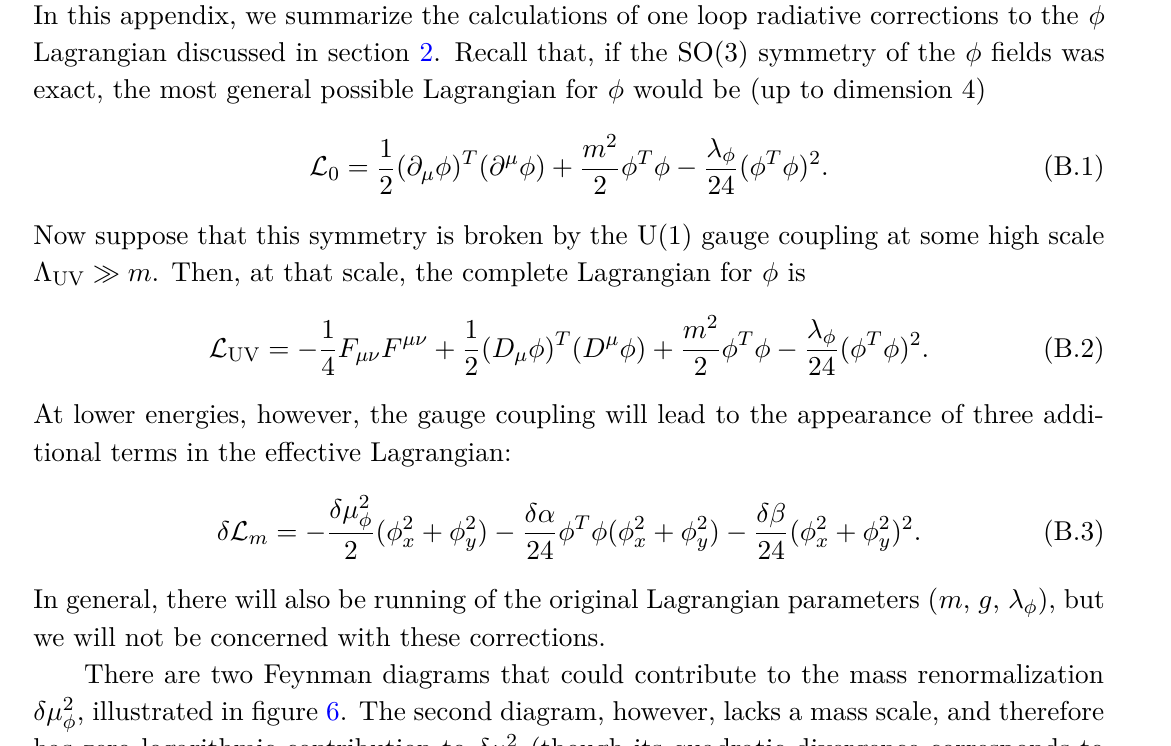
Figure 6 . The two one-loop diagrams contributing to the renormalization of the φ mass, µ 2 The second diagram gives no logarithmic running; the first is evaluated in the text. Note that the relevant quantity is the diagram’s zero-momentum limit, since we are interested in infrared effects; the momentum-dependent contributions lead to a field strength renormalization that does not contribute to the χ mass at lowest